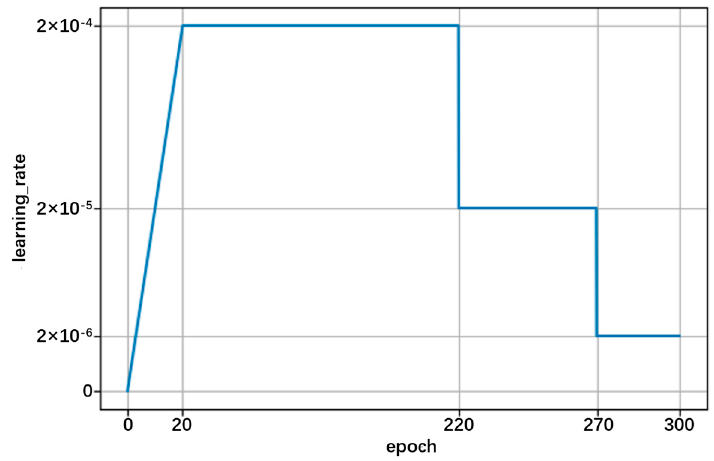
Figure 12. The relationship between learning rate and epoch.